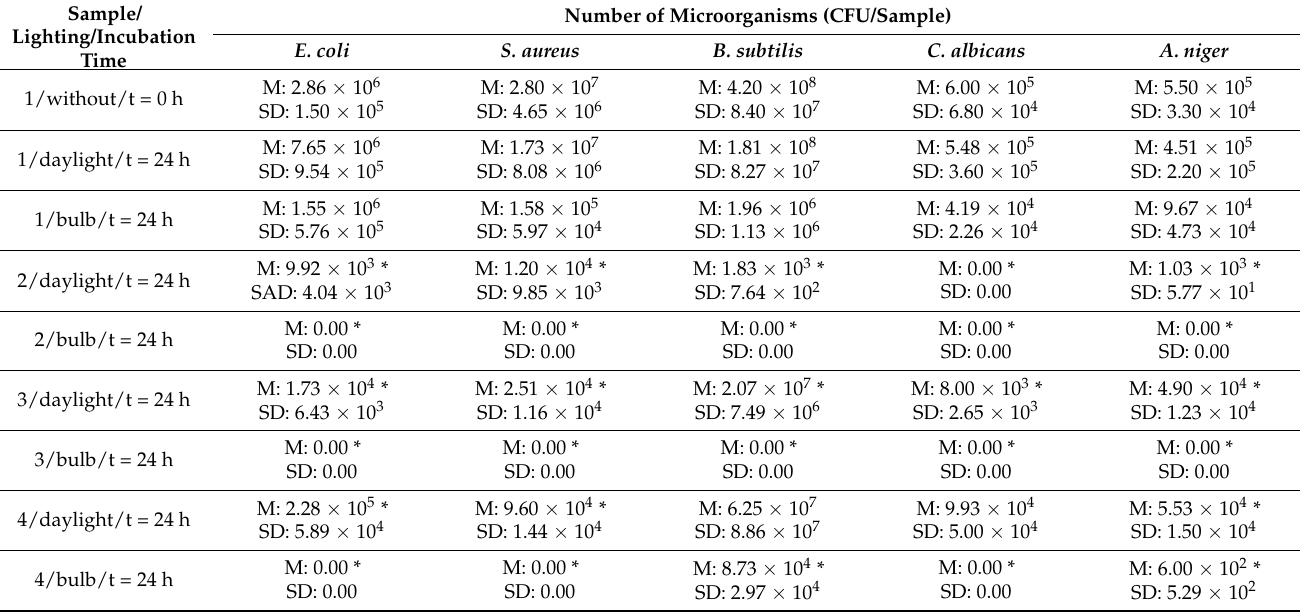
Table 3. Antimicrobial activity of the tested